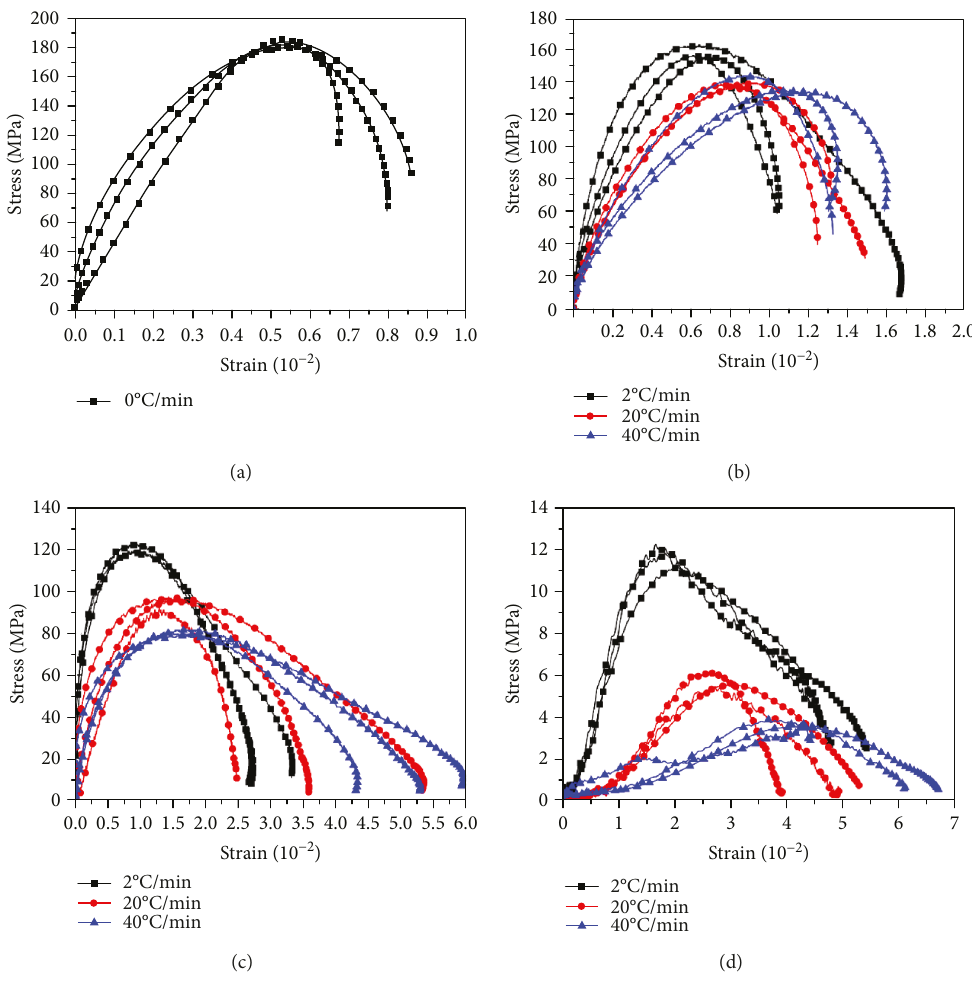
Figure 5: The stress – strain curves after treatments at di ff erent heating rates and temperatures: (a) 25 ° C; (b) 400 ° C; (c) 600 ° C; (d) 800 ° C.